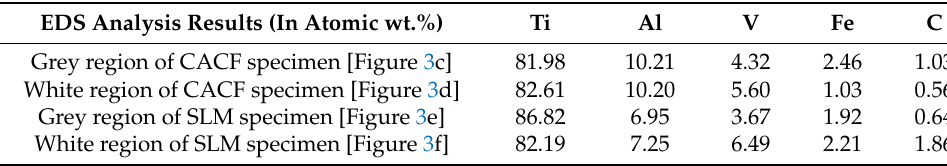
Table 2. EDS analysis results of CACF and SLM specimens. EDS Analysis Results (In Atomic